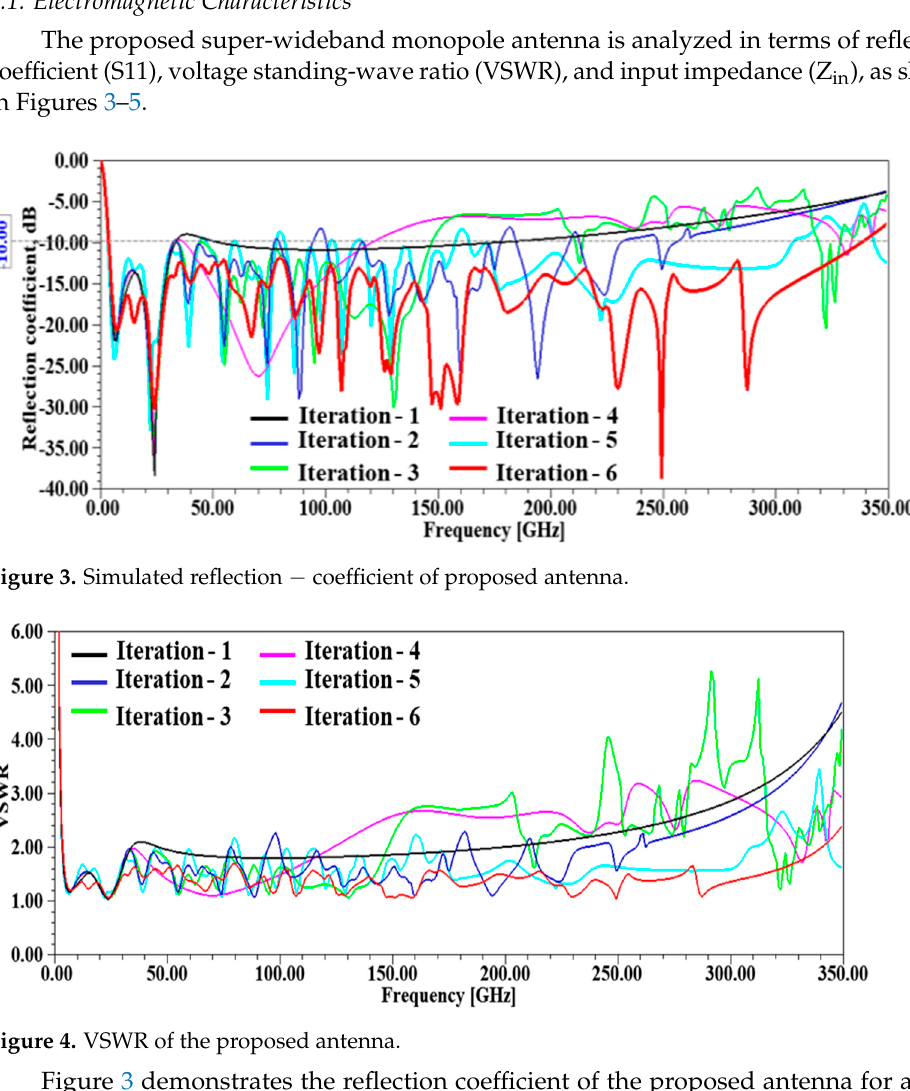
Figure 5. Simulated input impedance of designed antenna: real and imaginary part. Table 3. Input impedance of proposed antenna at selected resonant frequencies. S. No